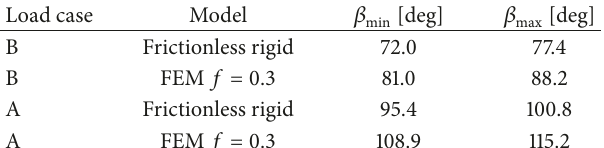
Table3:Designrangesofleadanglesinthetwoloadcasescalculated by means of the different models.